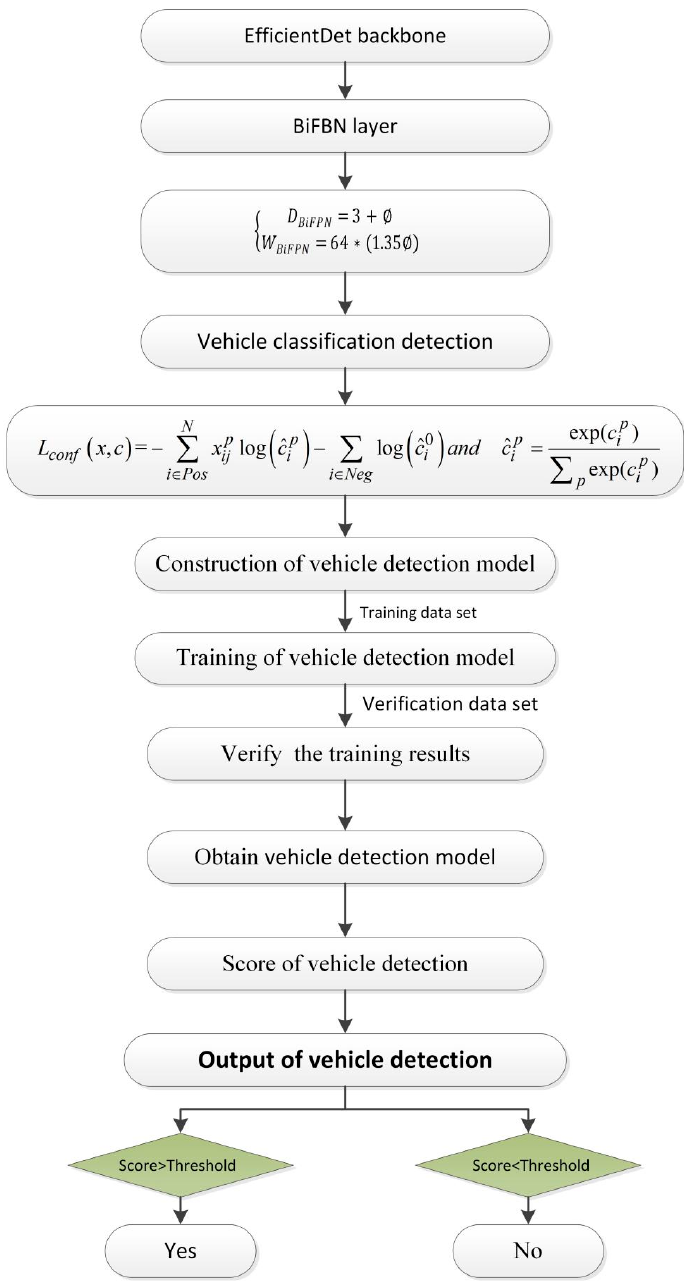
Figure 2. Vehicle detection diagram.